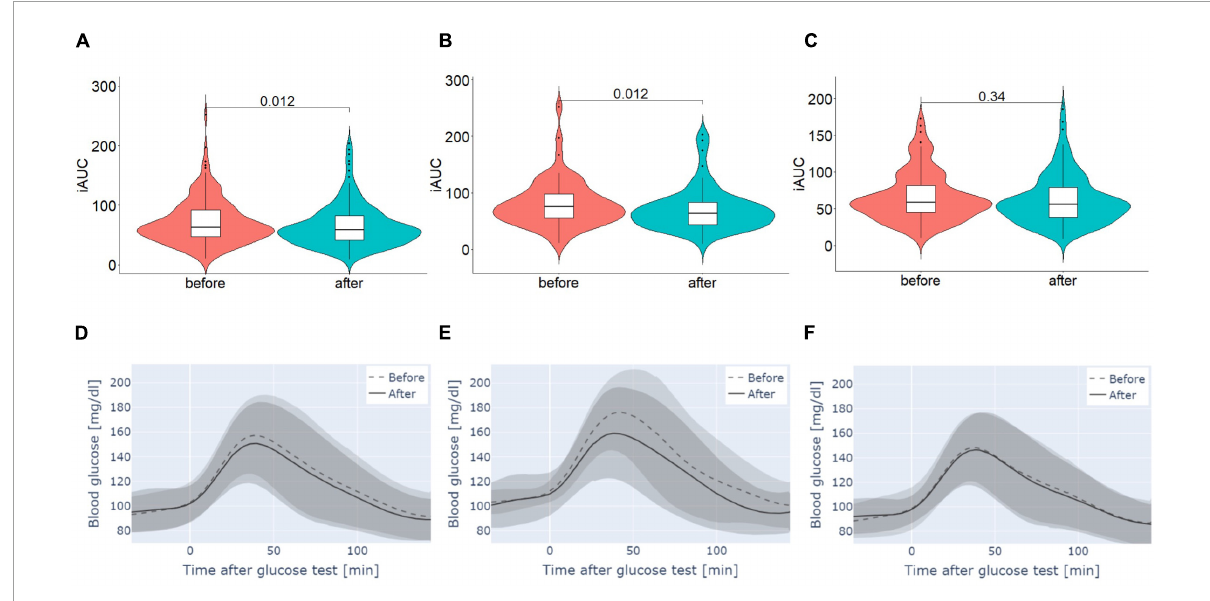
FIGURE3 Glycemic responses to a standardized glucose test meal measured for 120 min determined by iAUC (A–C) and blood glucose level [mg/dL] (D–F) before and after intervention (A,D) whole cohort, (B,E) prediabetic participants and (C,F) participants without prediabetes. (A–C) Data are presented as median ± IQR, p-values were estimated using Wilcoxon test. (D–F) Data are presented as median and IQR.